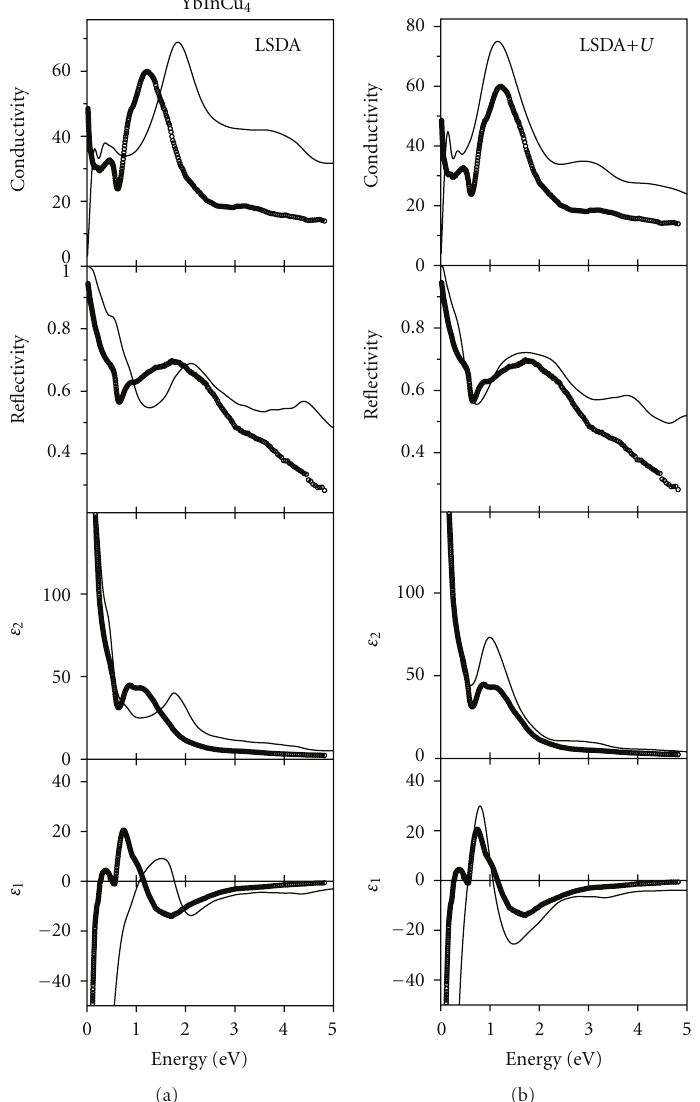
Figure 98: Comparison between the experimental (dots) optical conductivity σ ( ω ) (in 10 14 s − 1 ), reflectivity R , real part ε 1 ( ω ) and imaginary part ε 2 ( ω ) of the dielectric function of YbInCu 4 calculated within LSDA and LSDA+ U approximations (solid line) [475].